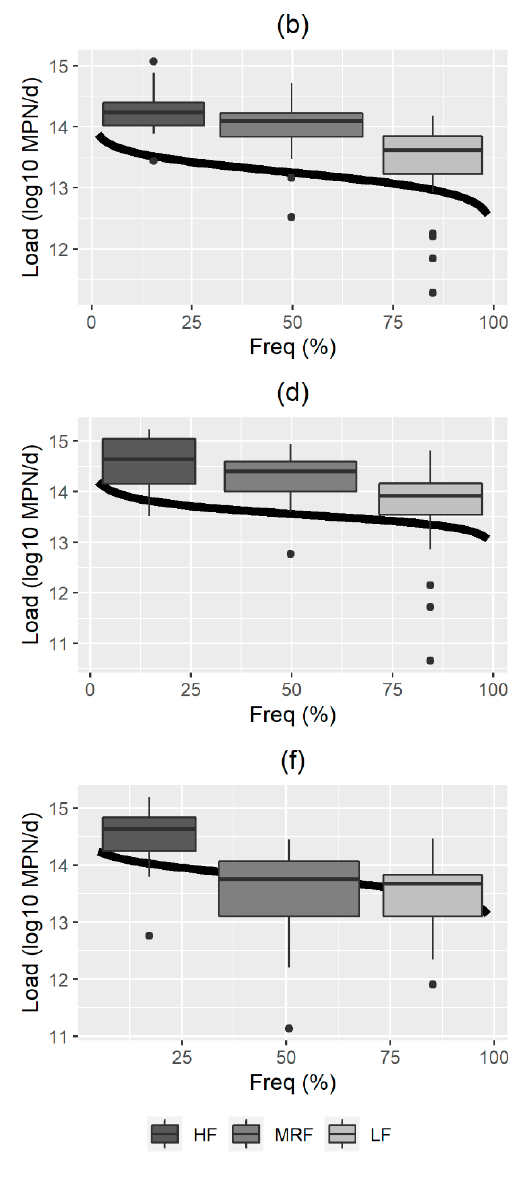
Figure 4. E. coli samples and box-plot per class of flow in relation to the TMDL curve for gauges: ( a , b ) RD025/56610000, ( c , d ) RD029/56659998 and ( e , f ) RD031/56696000. HF, high flows, MRF, Mid-range flows, LF, low-flows.